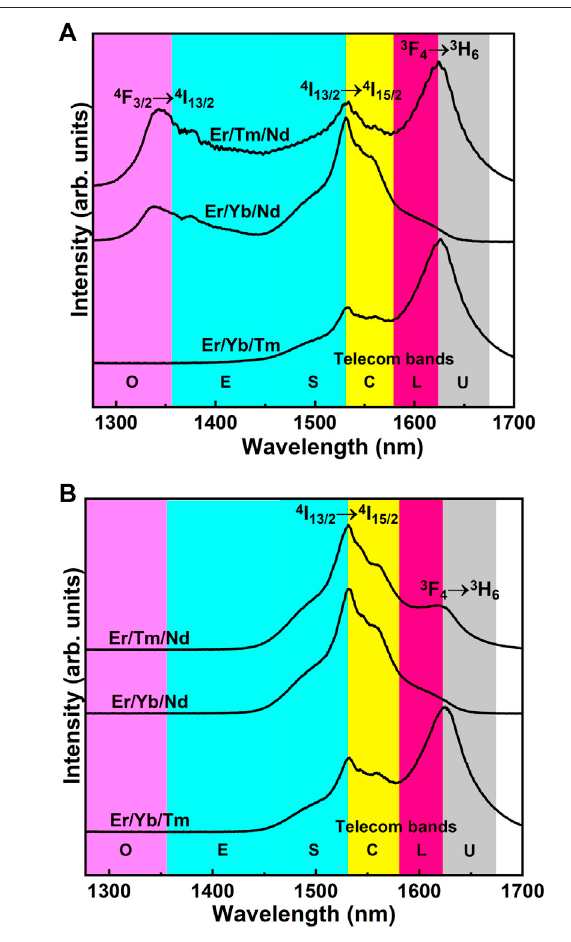
FIGURE 7 | PL emission spectra of triply doped SiO 2 -Ta 2 O 5 nanocomposites under excitation at (A) 808 nm and (B) 980 nm.